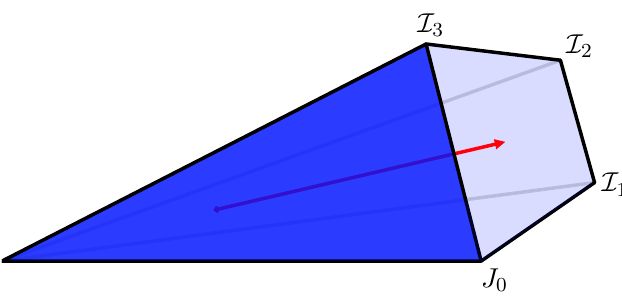
Figure 5 . The existence of a (cid:12)nite volume limit in the K(cid:127)ahler cone of B 3 where one of the K(cid:127)ahler moduli v 0 0 leads to a natural classi(cid:12)cation of the remaining K(cid:127)ahler cone generators into three ! 1 di(cid:11)erent sets according to their intersection properties with J 2 and J 0 (see [14] for details). 0 I 1 ::: 3 Limits of J -class A only allow for generators of type and , whereas limits of J -class B can only I 1 I 3 feature generators of type I 2